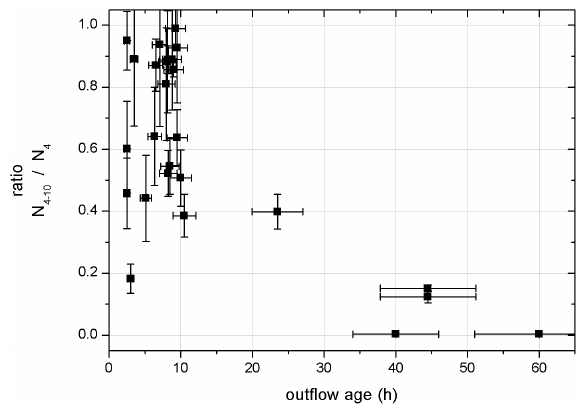
Fig. 17. Mean ratio of the number concentrations of nucleation mode particles (4–10 diameter range; N 4 − 10 ) to the total number of particles ( > 4nm; N 4 ) measured in MCS outflow during 26 different cases with varying outflow age between 2.5 and 60h. Each case represents an average value calculated from typically a few hundred original data points sampled at